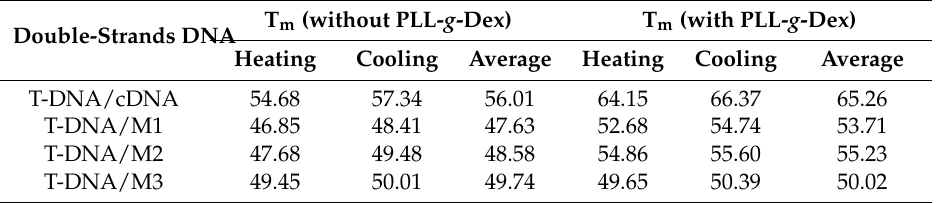
Table 2. T m of different double-strands DNA without or with PLL- g -Dex. Double-Strands